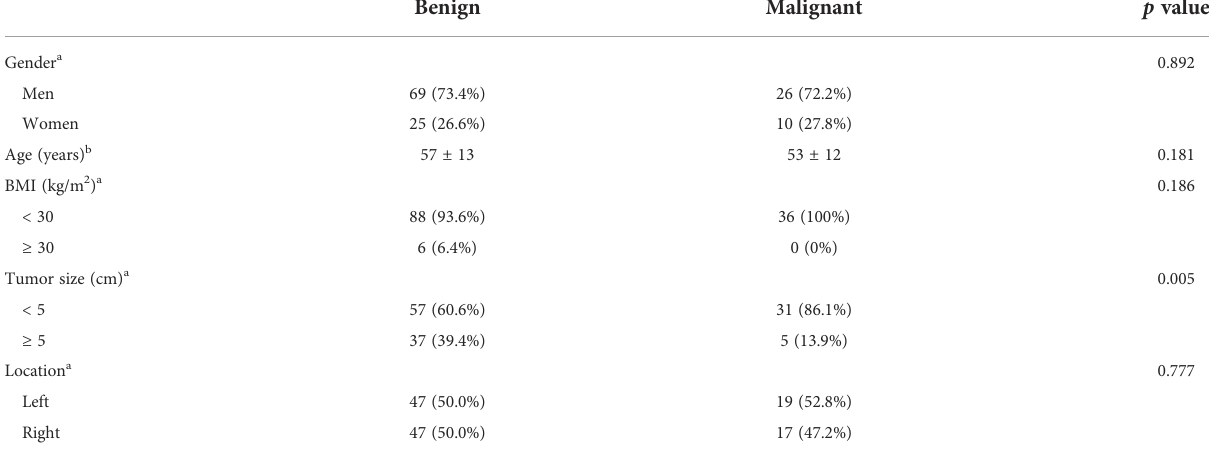
TABLE 1 Patient demographics and mass features between benign and malignant cystic renal masses. Benign Malignant p value